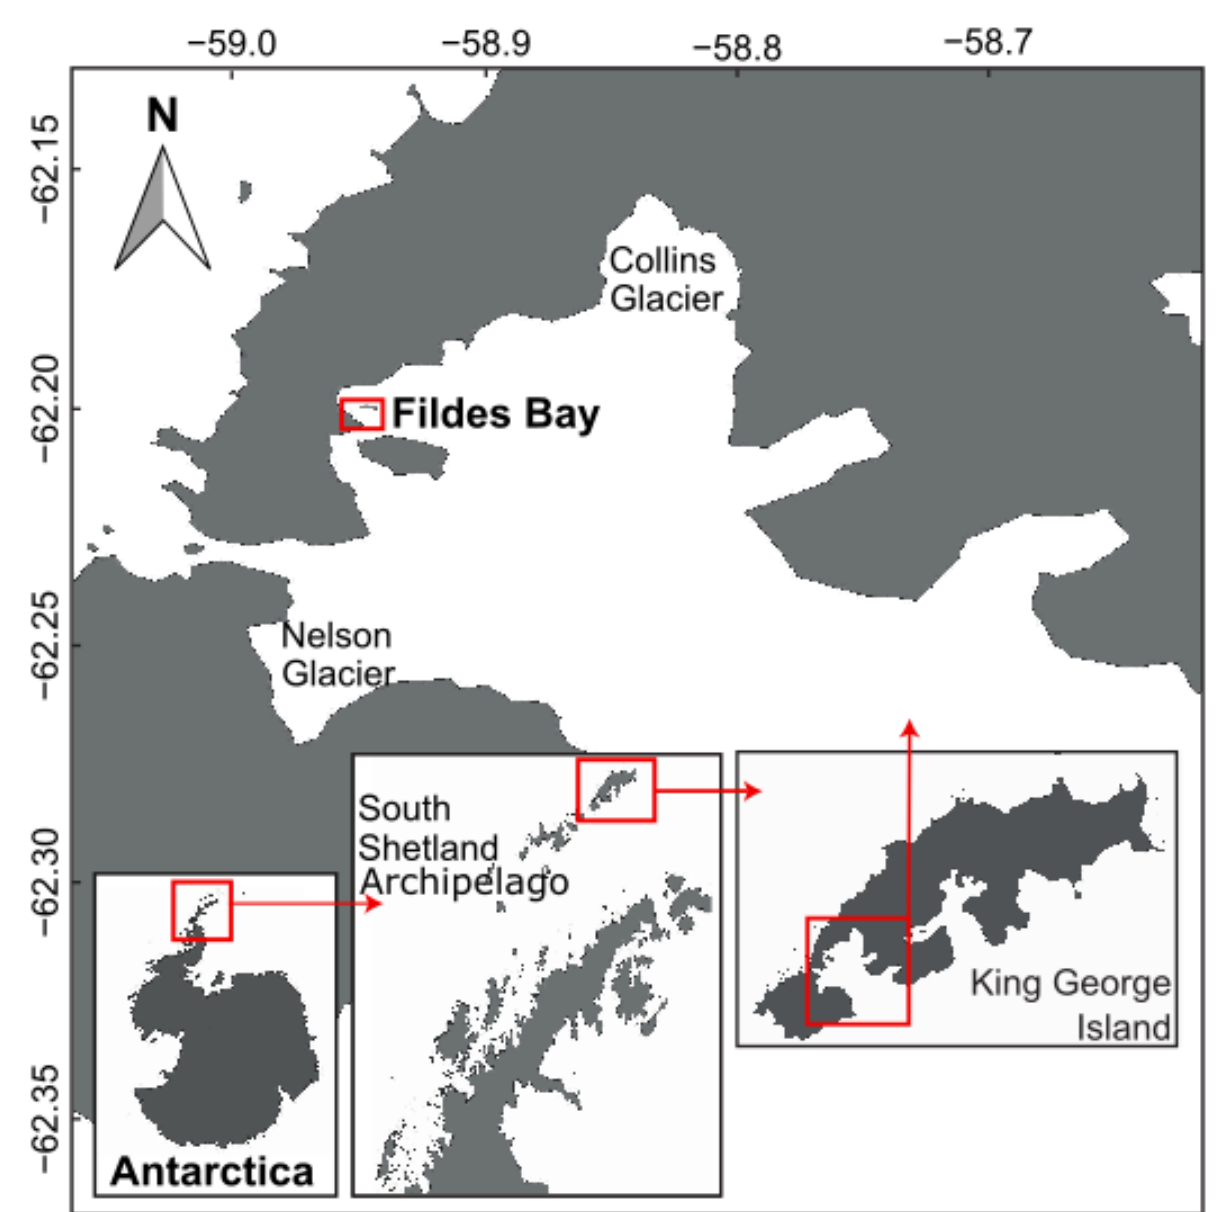
Figure 1. Location of the study area (approximately 62.20 ◦ S, 58.95 ◦ W) in Fildes Bay on the coast of King George Island in the northern region of the South Shetland Archipelago.